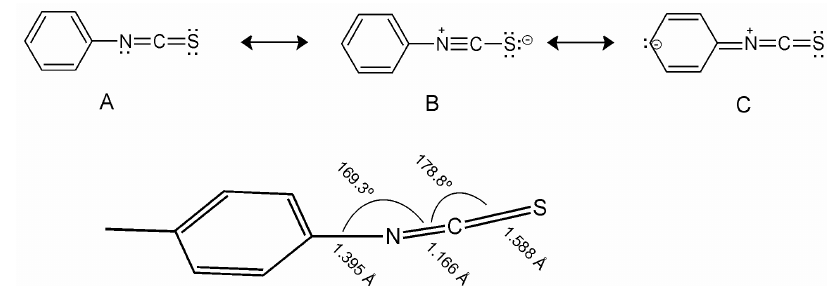
Figure 10. Resonance structures and geometry of NCS group bonded directly to the benzene ring.